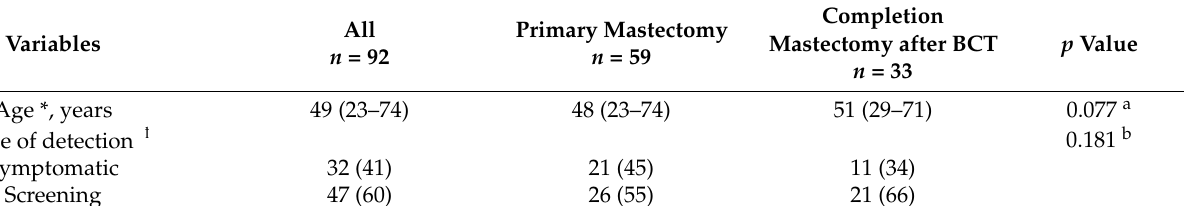
Figure 1. Flow chart of original patient population, excluded patients, and selected study cohort. Abbreviations: DCIS, ductal carcinoma in situ; IBR, immediate breast reconstruction.